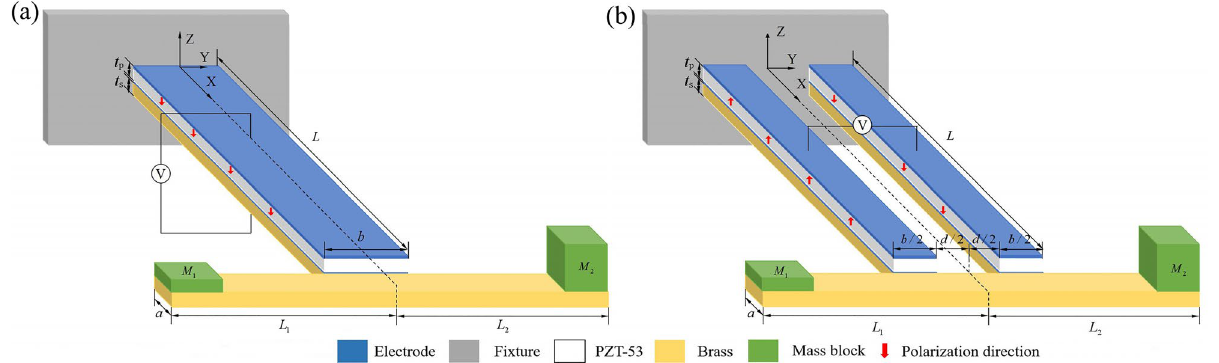
Figure 1. Schematics of PEH ( a ) SCB and ( b ) DCB undergoing coupled bending-torsion